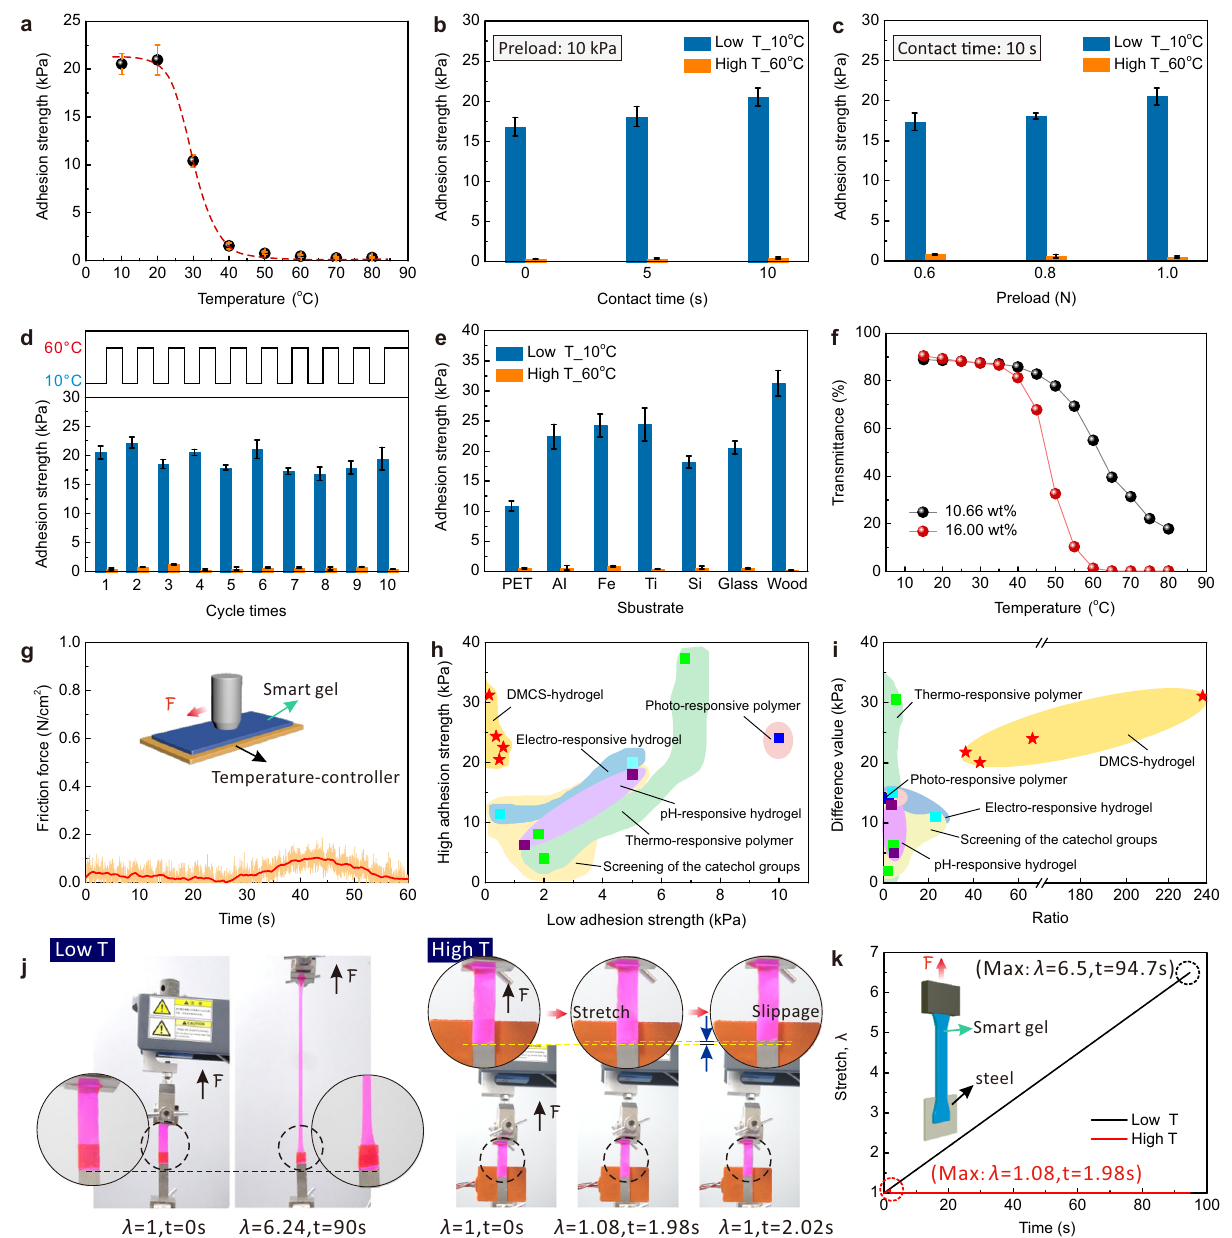
Fig. 3 | Switchable adhesion properties of hydrogels via dynamic multiscale contact synergy. a The relationship between the temperature and adhesion strength of DMCS-hydrogel. The effects of contact time ( b ) and preload c on adhesion strength at high and low temperatures against a glass probe. d Thermo- responsive switchable adhesion cycles of DMCS-hydrogel at high and low tem- perature. e The switchable adhesion properties of the smart hydrogel can be applied to a variety of solid substrates including inorganic and organic surfaces. f The variation of LCST in DMCS-hydrogel with different pNIPAAm content. Transmittance vs. temperature captured at 400nm wavelength by UV-vis spec- trometer. g Frictioncurvesintimedomainathightemperature.Ultra-lowadhesion